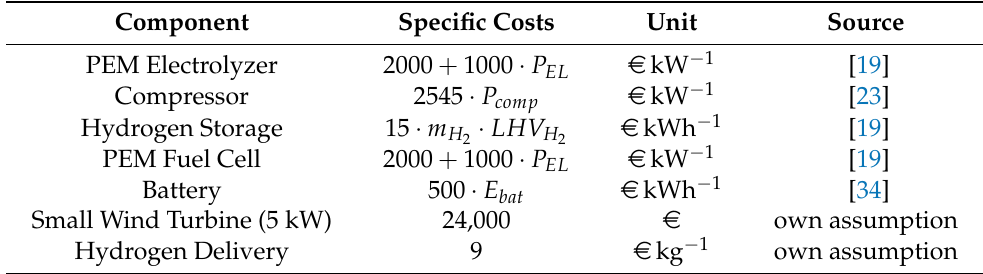
Table 4. Specific investment costs of the system